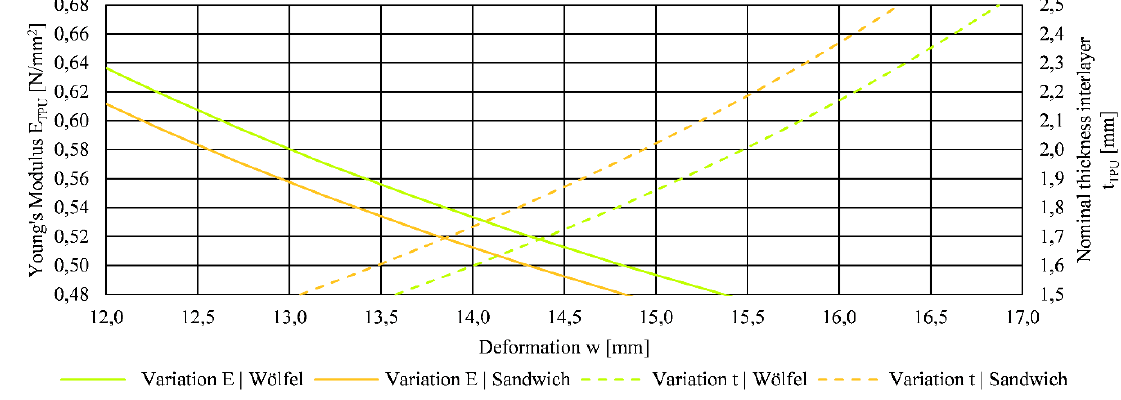
Fig. 3 Comparison between extended theory of the approximate solution by Wölfel and sandwich theory for a thin glass-polycarbonate composite panel analysed in the four-point bending